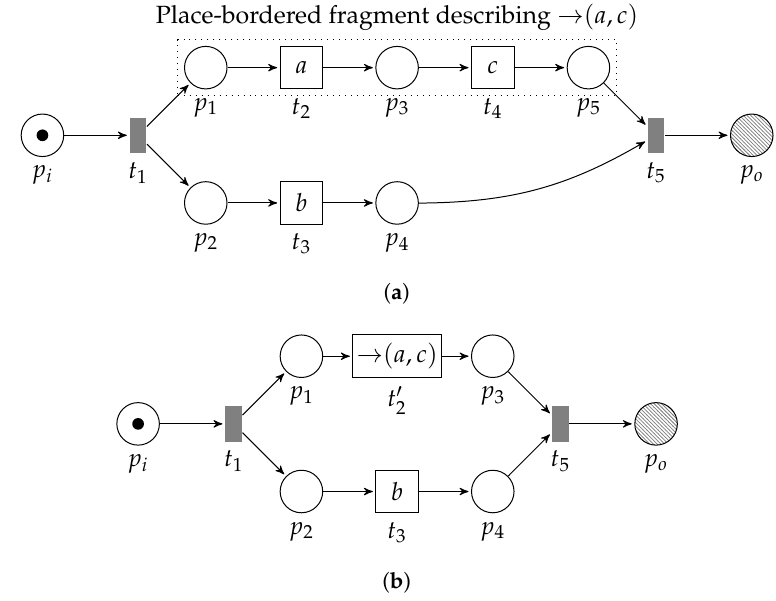
Figure 7. Example WF-net (and a corresponding reduction) in which we are able to detect the feasible pattern → ( a , c ) . The language of the original net (Figure 7a) is